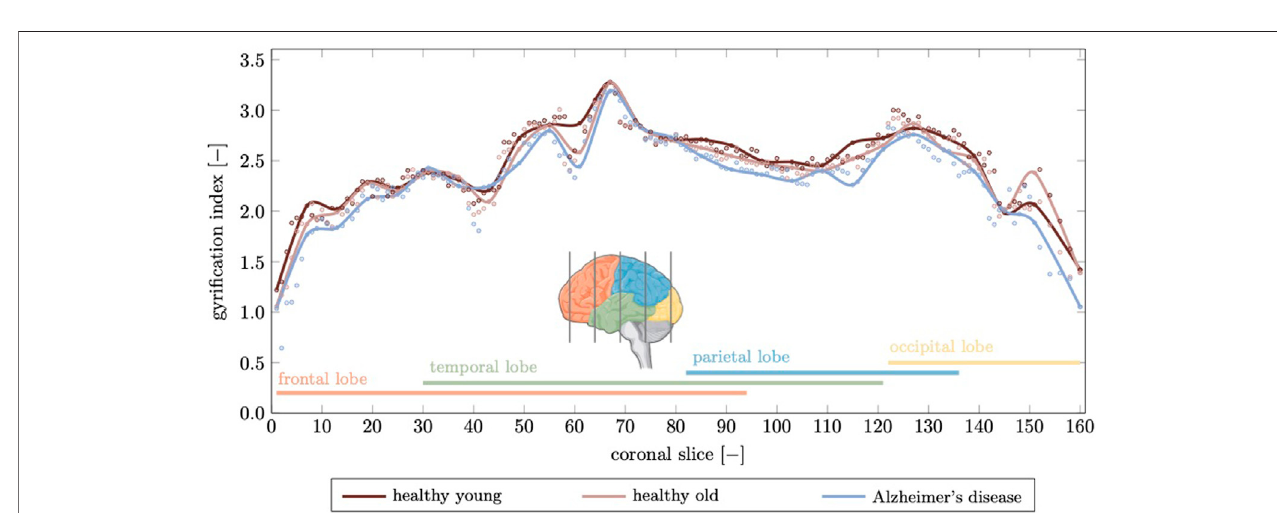
FIGURE 11 | The gyri fi cation index is a measure for the degree of folding. Here, we compute a gyri fi cation index for 164 coronal slices generated from our fi nite elementmodel. Wecompare thegyri fi cation index fortheyoungbrain,aged brain, and inAlzheimer ’ s disease and observe anoticeabledecrease inAlzheimer ’ sdisease inthetemporalandparietallobeswhilethefrontallobe,whichisaffectedleastintermsofatrophy,showsonlysmalldeviations.Peakgyri fi cationisobservedinthevicinity of the sylvian fi ssure which is widens signi fi cantly as discussed before.